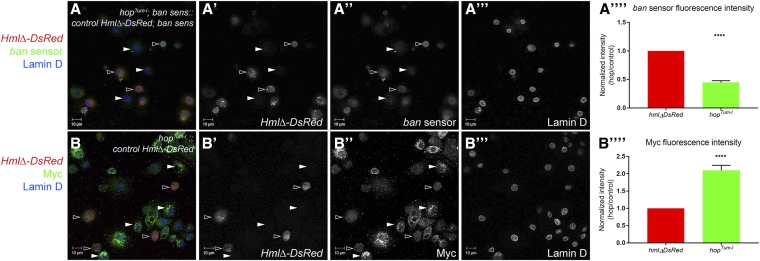
Expression of Yki targets ban and Myc are significantly increased in hopTum-l hemocytes. (A and B) Mixed-cell experiments of hemolymph bleeds where control hemocytes are DsRed-positive and hopTum-l hemocytes are DsRed-negative. Both genotypes express the ban sensor. Open arrowheads (A–A”) indicate DsRed-positive control hemocytes that have appreciable levels of GFP, indicating that ban miRNA is low in these cells. By contrast, solid arrowheads (A–A”) indicate DsRed-negative hopTum-l hemocytes that have low levels of GFP, indicating that ban miRNA is higher in these cells. (A””) Quantification of fluorescence intensity of the ban sensor. hopTum-l hemocytes (green bar) have significantly lower ban sensor levels than the control (red bar) (P < 0.0001). (B) Mixed-cell experiment with anti-Myc (green). Open arrowheads (B–B”) indicate DsRed-positive control hemocytes that have appreciable levels of Myc. Solid arrowheads (B–B”) indicate DsRed-negative hopTum-l hemocytes that have higher levels of Myc than controls. (B””) Quantification of fluorescence intensity of Myc. hopTum-l hemocytes (green bar) have significantly higher levels of Myc than the control (red bar) (P < 0.0001). DsRed is red and Lamin D, which marks the nucleus, is blue in (A and B). Bar, 10 μM. GFP, green fluorescent protein; miRNA, micro RNA; Yki, Yorkie.